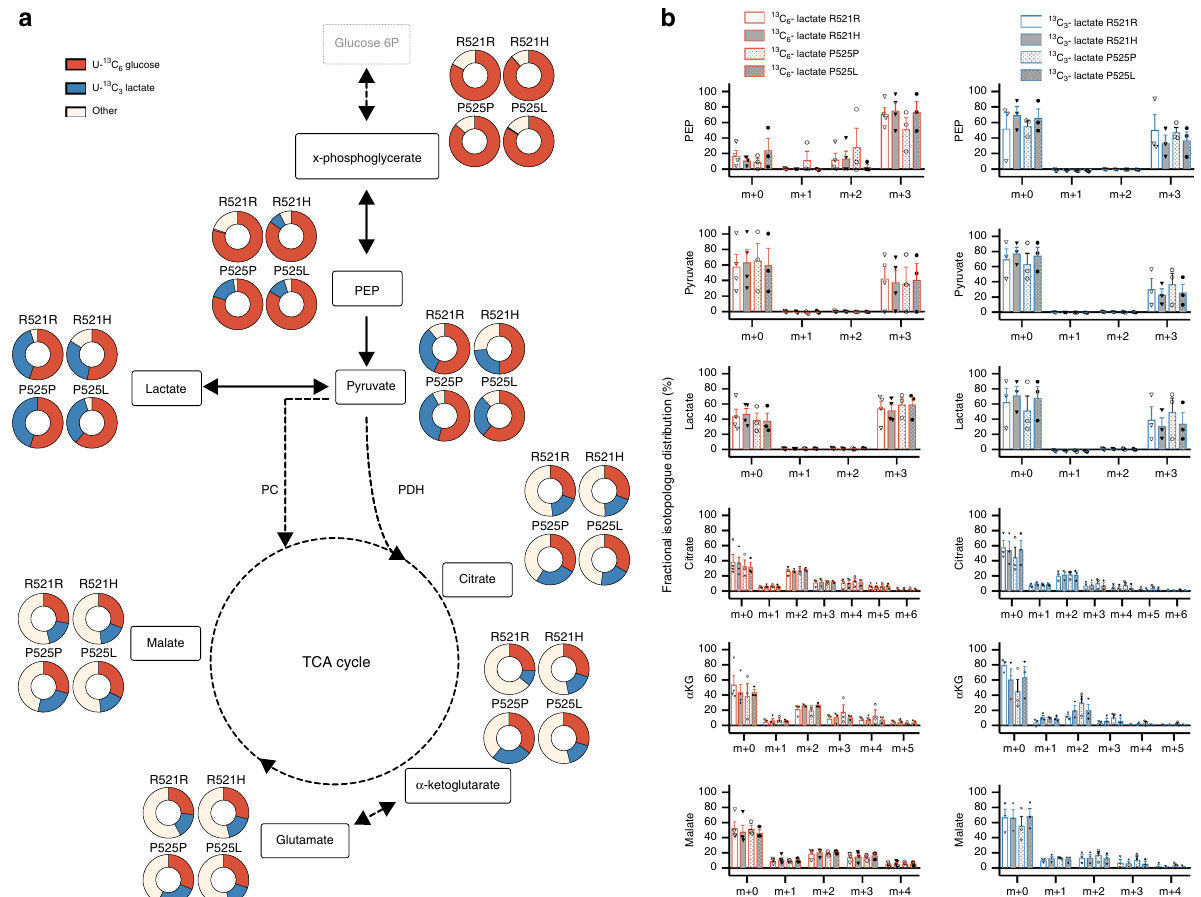
Fig. 5 Metabolic fate of glucose and lactate in MNs derived from FUS – ALS patients and isogenic controls. a Fractional contribution of uniformly labelled 13 C glucose (red) and uniformly labelled 13 C lactate (blue) to metabolites from glycolysis and TCA cycle in patient (R521H or P525L) and isogenic control (R521R or P525P) motor neurons. b Relative abundance of each isotopologue for speci fi c metabolites in patient and isogenic control motor neurons. The data represent mean ± s.e.m. from three independent experiments, with individual data points shown. Two-way ANOVA analysis with Tukey post hoc test was used to compare FUS-patients and isogenic controls, but did not show differences ( p > 0.05). Dark grey bars indicate FUS-patient cell lines. Light grey bars indicate isogenic controls from these patients. Bar fi ll patterns show the corresponding patient and isogenic control. Thin black arrows represent direct metabolic pathway connections; dashed arrows indicate that additional intermediate reactions are involved in a metabolic pathway. Source data are provided as a source data fi le. 13 C 6 -glucose uniformly labelled glucose, 13 C 3 -lactate uniformly labelled lactate, PEP phosphoenolpyruvate, PC pyruvate carboxylase, PDH pyruvate dehydrogenase, α KG alpha-ketoglutarate, TCA tricarboxylic